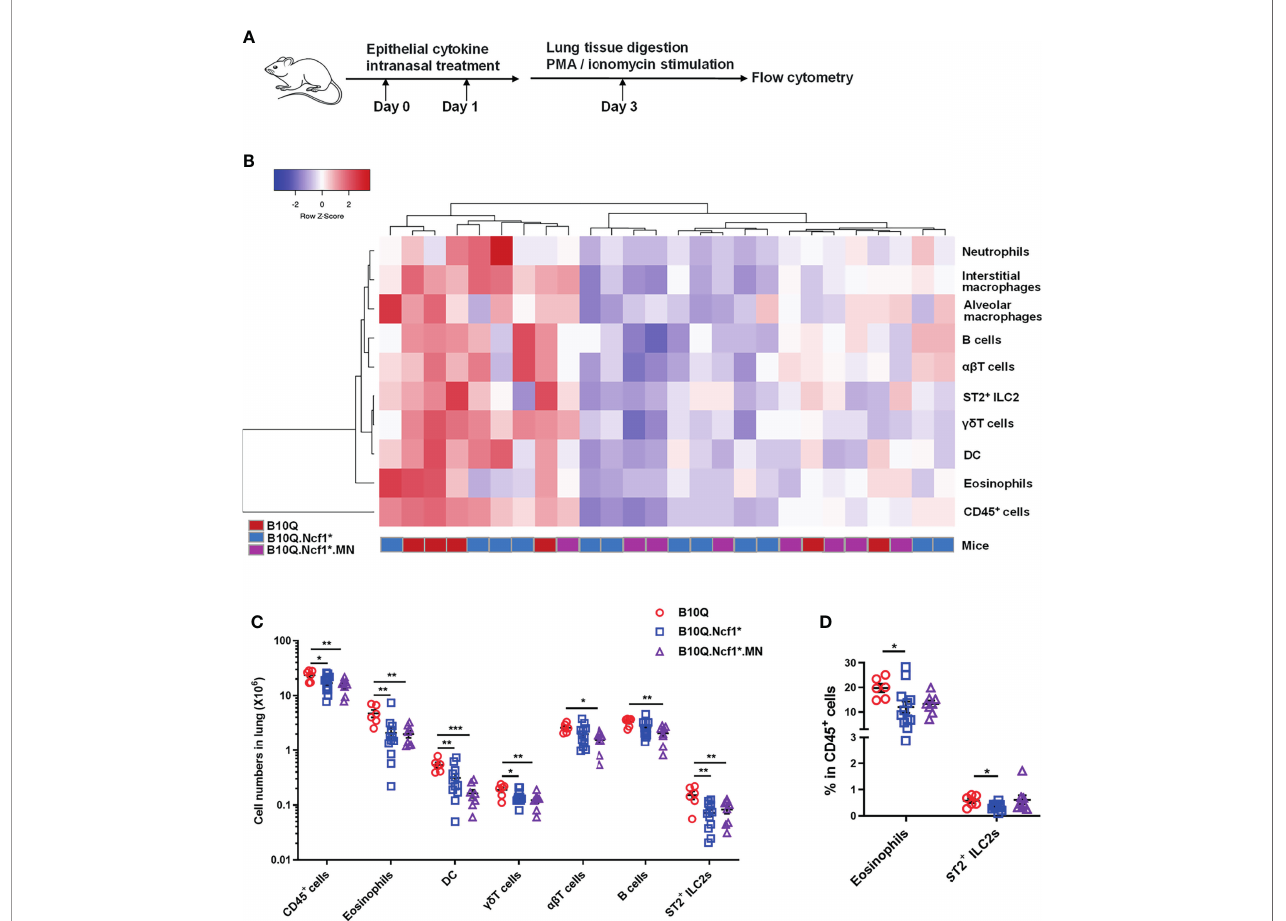
FIGURE 5 | IL-33 induced lung in fl ammation is regulated by Ncf1 independent on macrophages. (A) IL-33 was intranasally administered to mice to induce lung in fl ammation (n = 6-12 per group). (B, C) The numbers of immune cells in the whole lung tissues were analyzed by fl ow cytometry, and heat map with cell pro fi le of each mouse, and the statistical analysis of cells with difference among groups are shown. (D) The proportion of eosinophils (CD11b + SiglecF + cells) and ILC2 (ST2 + Lineage - cells) in CD45 + cells of lung are shown in histogram. All values are expressed as means ± SEM. * P < 0.05, ** P < 0.01 and *** P < 0.001, using one ‐ way ANOVA with post ‐ hoc comparison (Fisher ’ s)